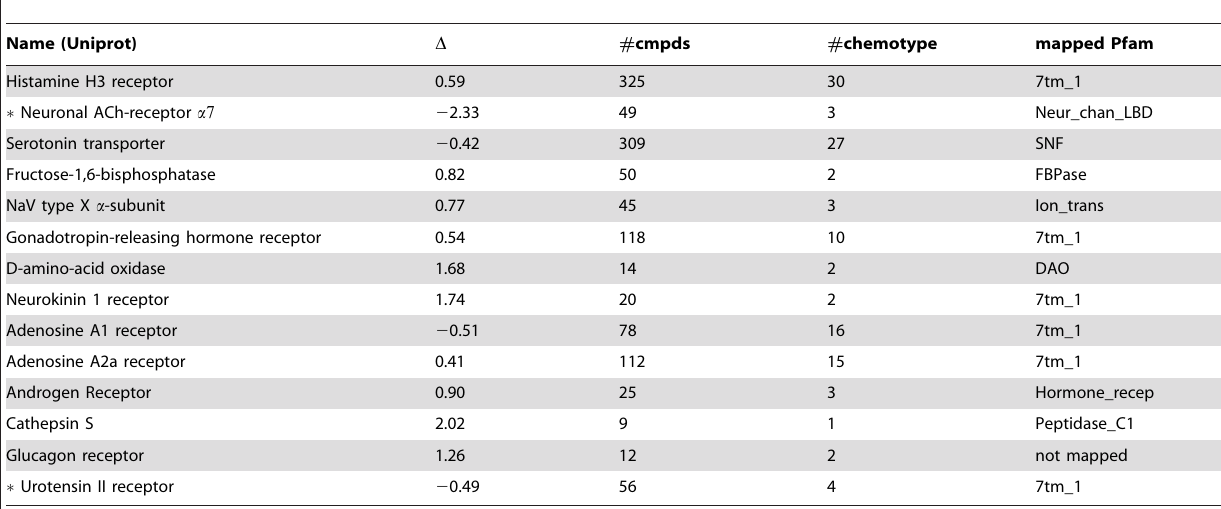
Reported are target pairs where observed differences in binding affinity deviate significantly from the control distribution. D represents mean potency differences. Positive values of D designate preferential binding to the human ortholog and negative values preferential binding to the rat ortholog. Asterisks mark values which are artifacts of faulty annotation. The number of tested compounds is reported in the column # cmpds and # chemotypes reports the number of chemotypes determined by hierarchical clustering.